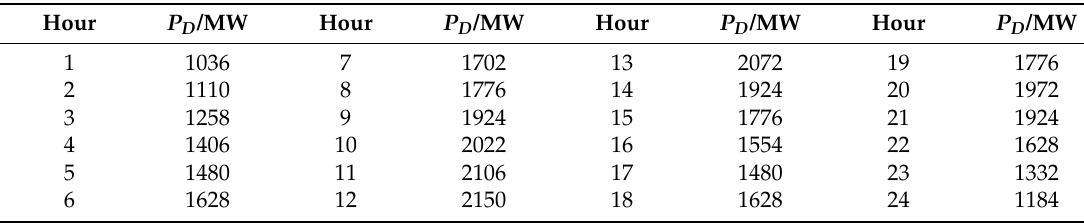
Table 1. Load demands for 24 h (10-unit